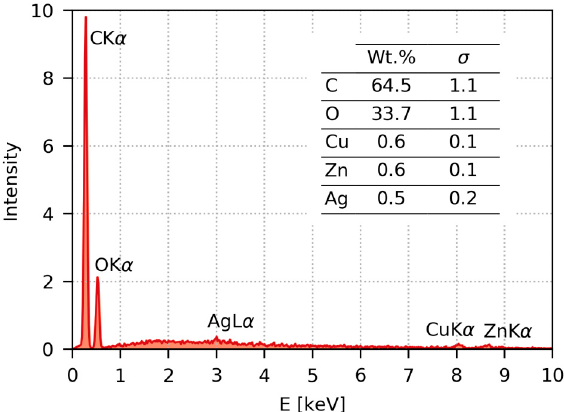
Figure 6. Typical EDX (energy-dispersive analysis of X-rays) spectrum recorded from the surface of PET immobilized at laser fluence of 14 mJ cm − 2 . The inset table shows results of semi-quantitative standardless EDX analysis.